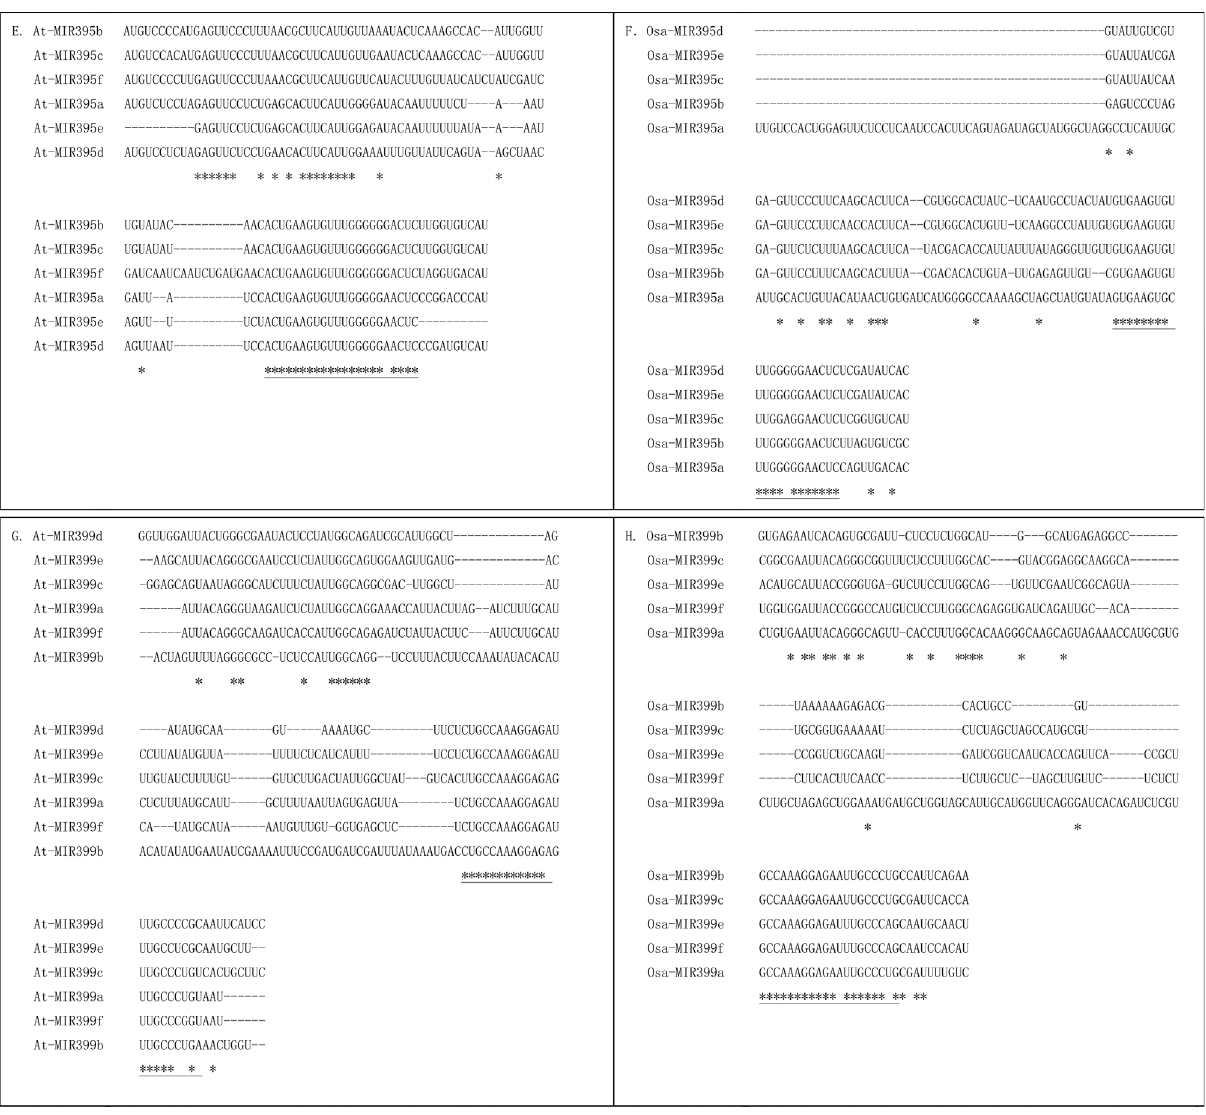
Figure 5 (cont.) - Sequence alignment of Arabidopsis and Oryza miRNAs. *Conserved nucleotides. The core sequences of the miRNAs are underlined. At: Arabidopsis thaliana ; Os: Oryza sativa